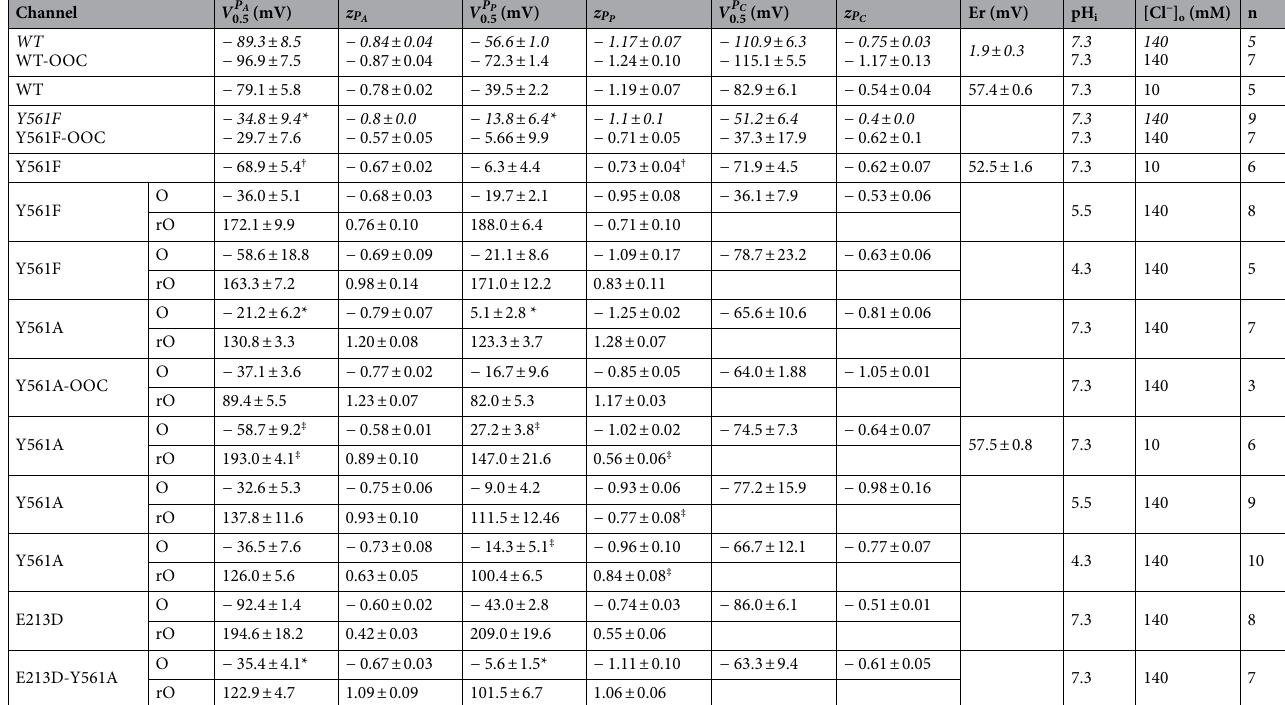
Table 1. Effect of [H + ] i and [Cl − ] O on the voltage-dependent parameters of WT and mutants CLC-2 channels. z P V P A V P P 0.5 = voltage to reach an open probability of 0.5, 0.5 = A = apparent charge of the open-closed transition, P C voltage to reach a 0.5 open probability of Glu gate , z P P = apparent charge of the Glu gate , V 0.5 = voltage to reach a 0.5 open probability of the common gate, z P C = apparent charge the common gate. These parameter values were calculated by fitting the data to the Boltzmann equation (Eq. 3). Er = reversal potentials determined by current–voltage relationship interpolations. Data were collected from HEK 293 cells and from cut-open oocytes (OOC). Within a column, those mean values labelled with *, †, or ‡ were statistically different to that of to WT, Y561A, or Y561F, respectively. Reference values of to WT, Y561A, and Y561F were calculated from recording obtained under control conditions (pH i = pH e = 7.3 and [Cl − ] i = [Cl − ] e = 140 mM). Mean values were compared using a one-way ANOVA with a Tukey post hoc test with p < 0.01.